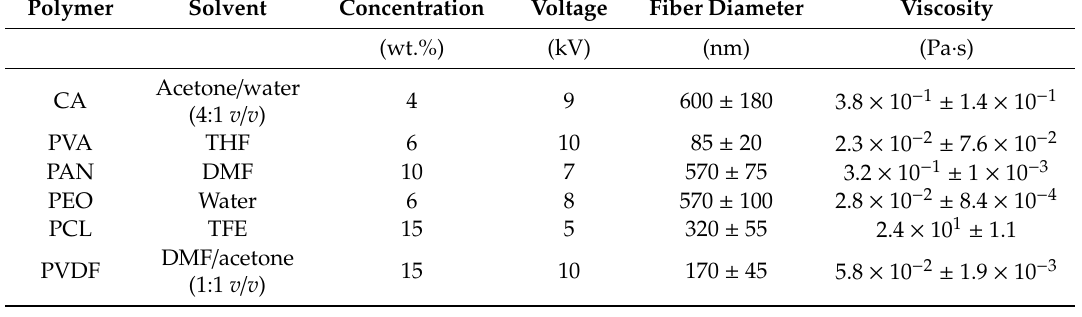
Table 1. Electrospinning parameters and measured nanofiber diameter.